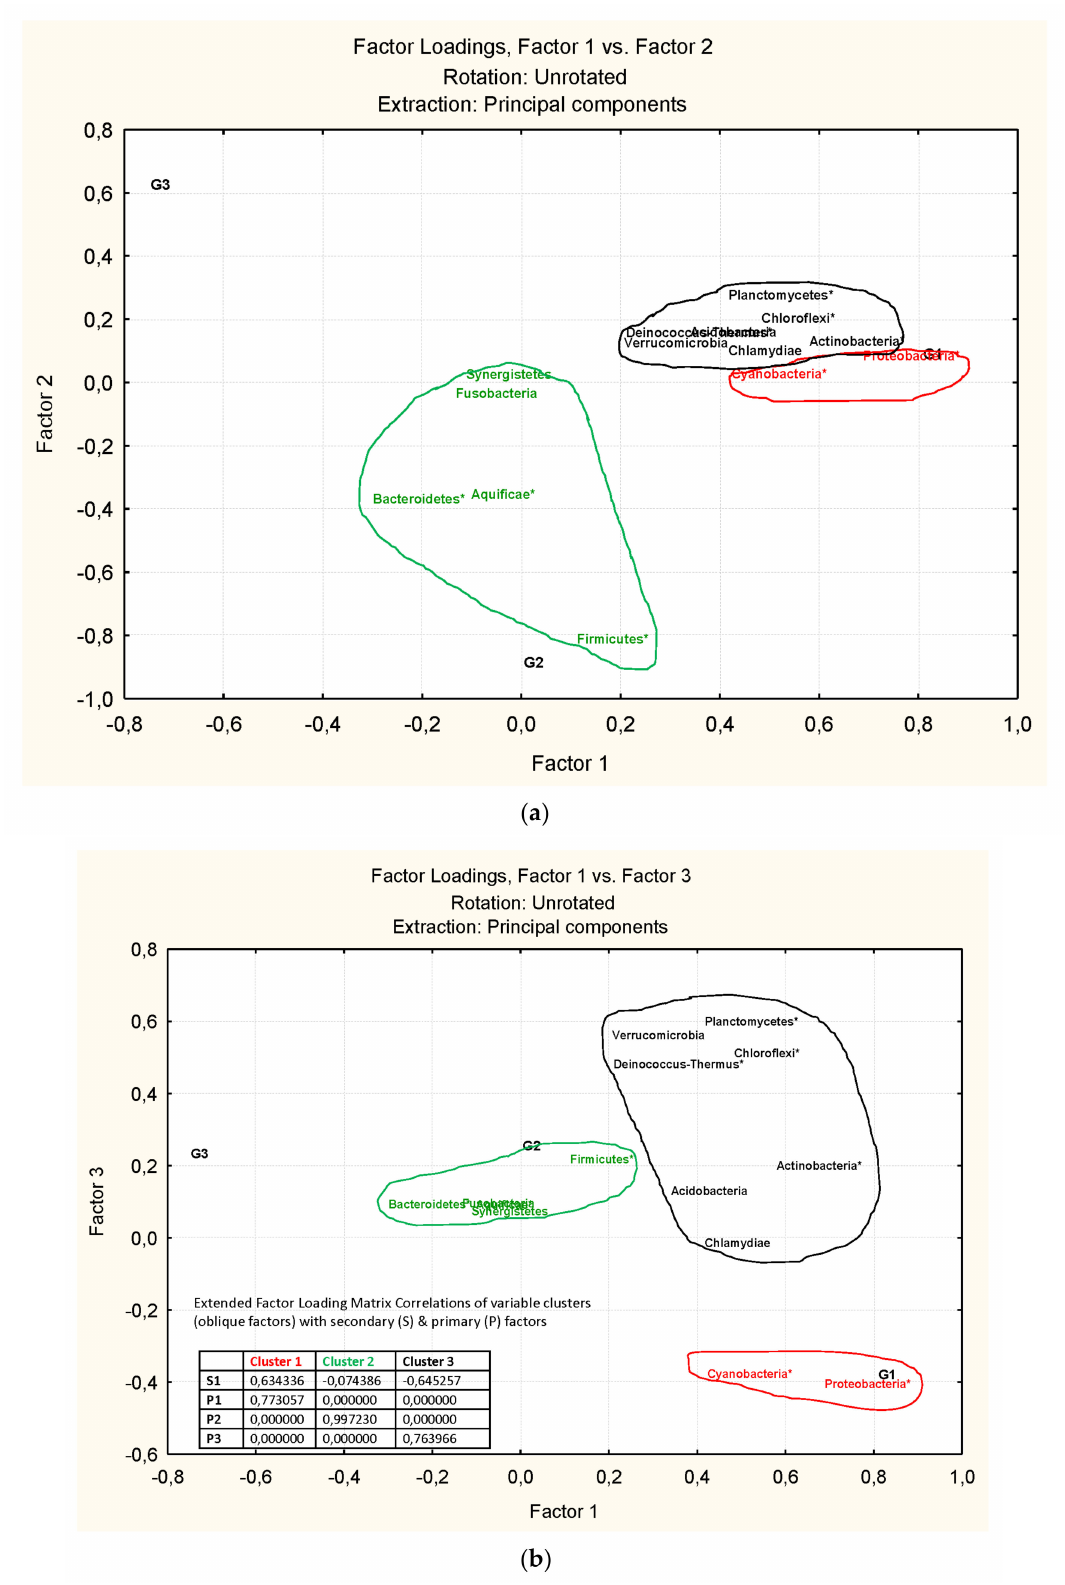
Figure 3. Factorial Analysis considering the anisakids samples and bacteria at phyla level. In the factorial space defined by Factor 1 vs. Factor 2 ( a ) and Factor 1 vs. Factor 3 ( b ) can be seen the correspondence with the classified clusters of Figure